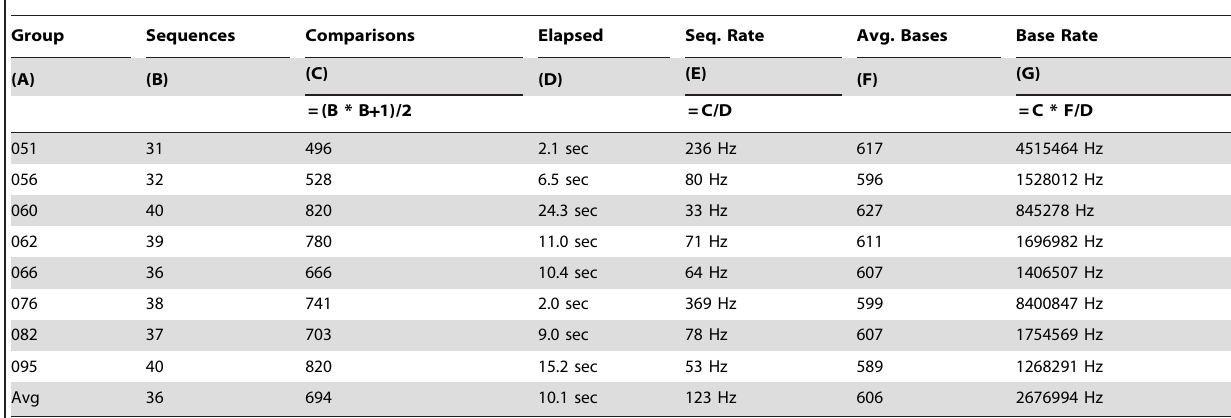
Table 1. Benchmark results for sequence comparison using the W-curve.